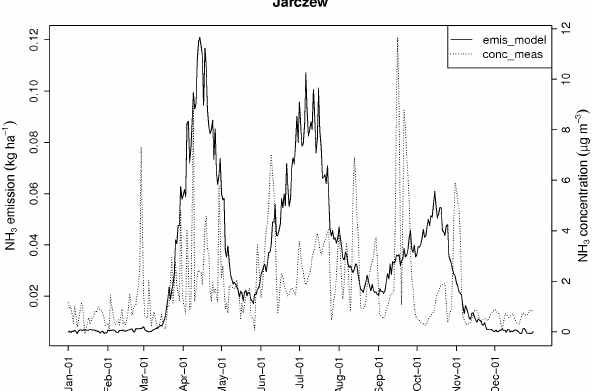
Figure 7. Modelled emission (POLREGUL) and measured concen- tration for the Jarczew